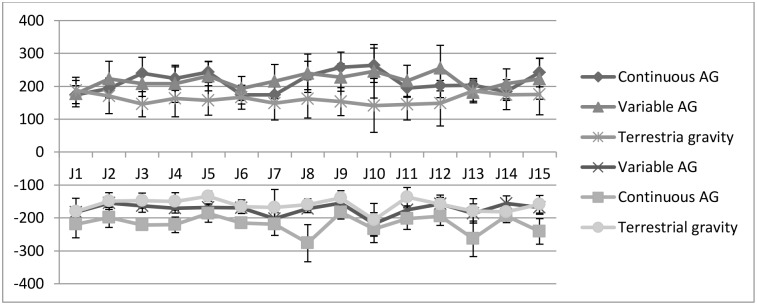
Mean (± SD) peak pitch angular velocities during each jumping session and in each condition.Subsequent jumps are labeled as J1 to J 15.